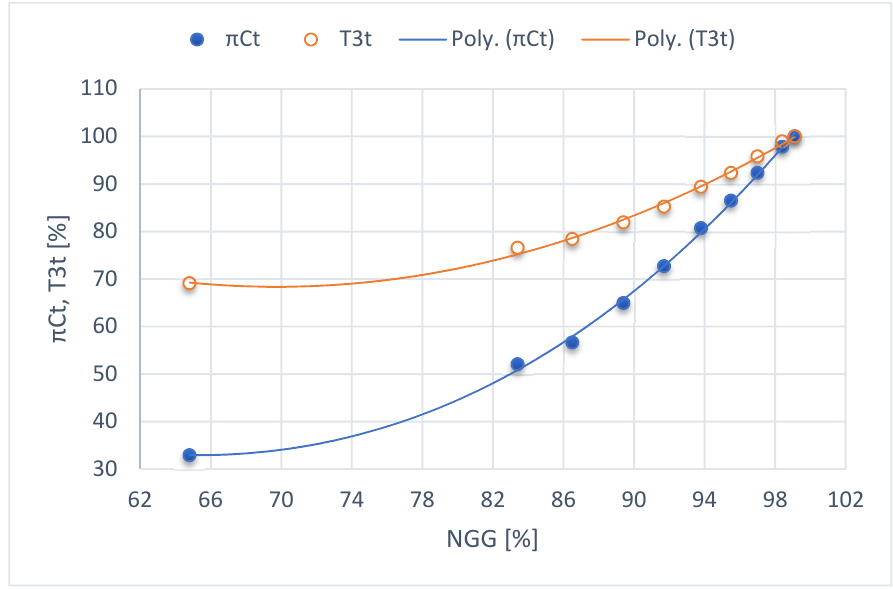
Figure 12. Fuel flow and mass air flow percentage variation.